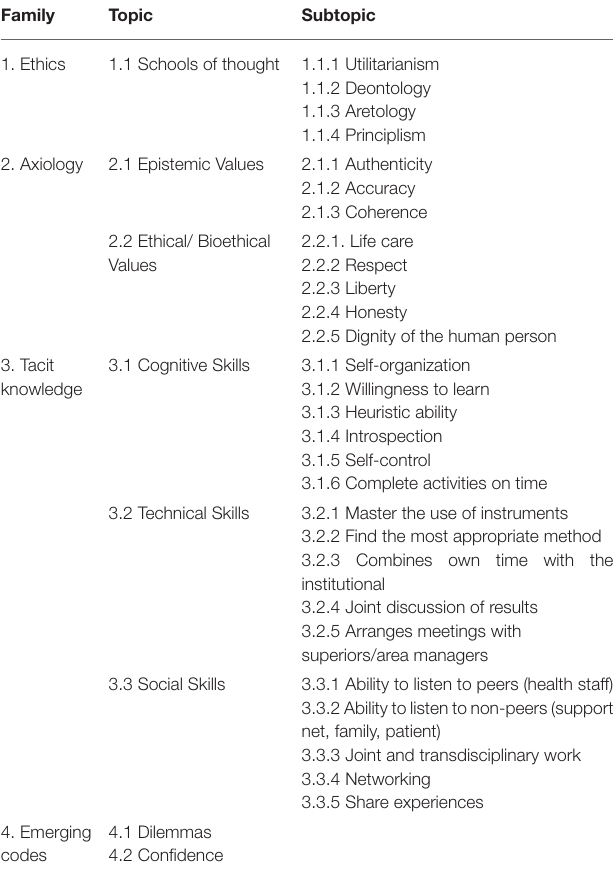
TABLE 1 | Ethics, Axiology, and Tacit knowledge codes to perform the qualitative analysis in Atlas.ti.